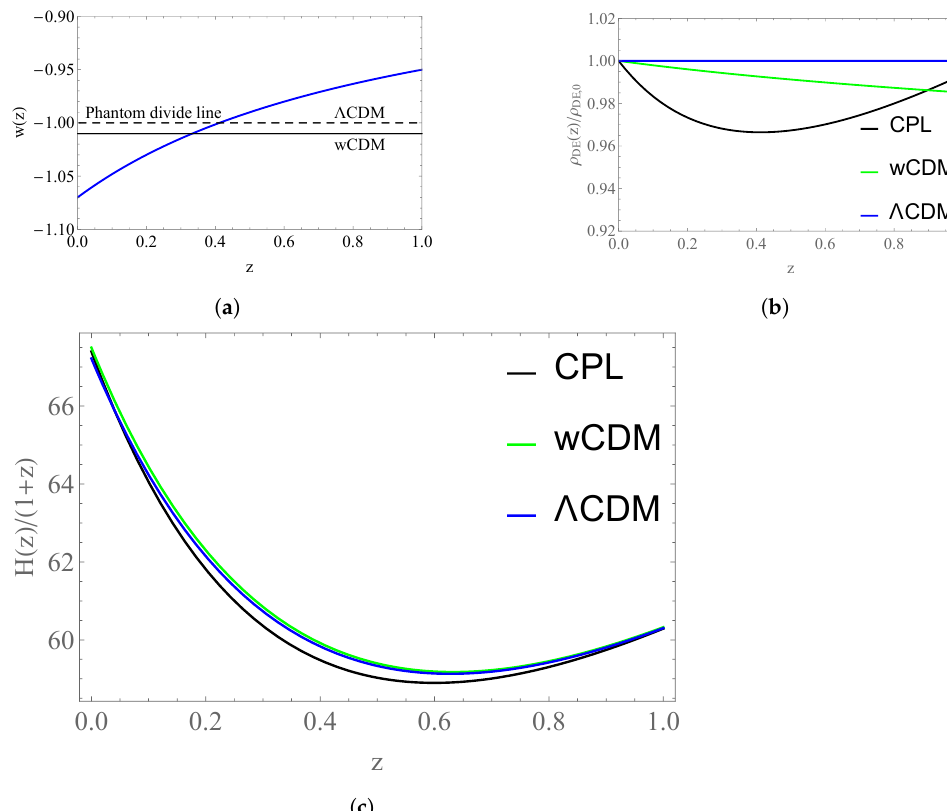
Figure 23. Plots for the field reconstruction: ( a ) Plot of the equation of state w in terms of the redshift z for the three models considered. ( b ) Plot of the energy density ρ DE in terms of the redshift z for the three models considered. ( c ) Plot of the fraction H models